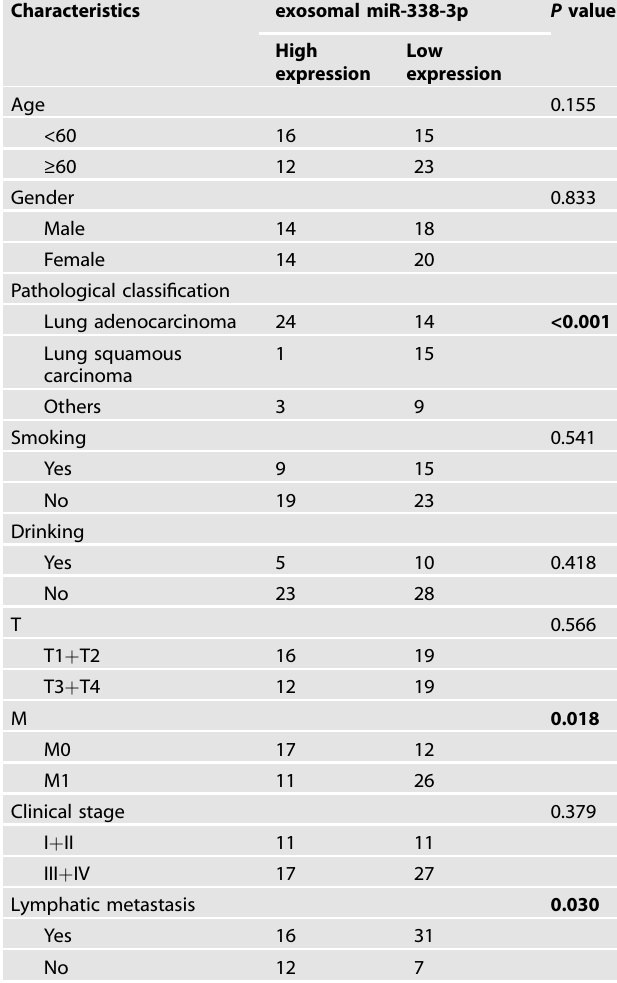
Table 2. The clinical characteristics of exosomal miR-338-3p in NSCLC patients.